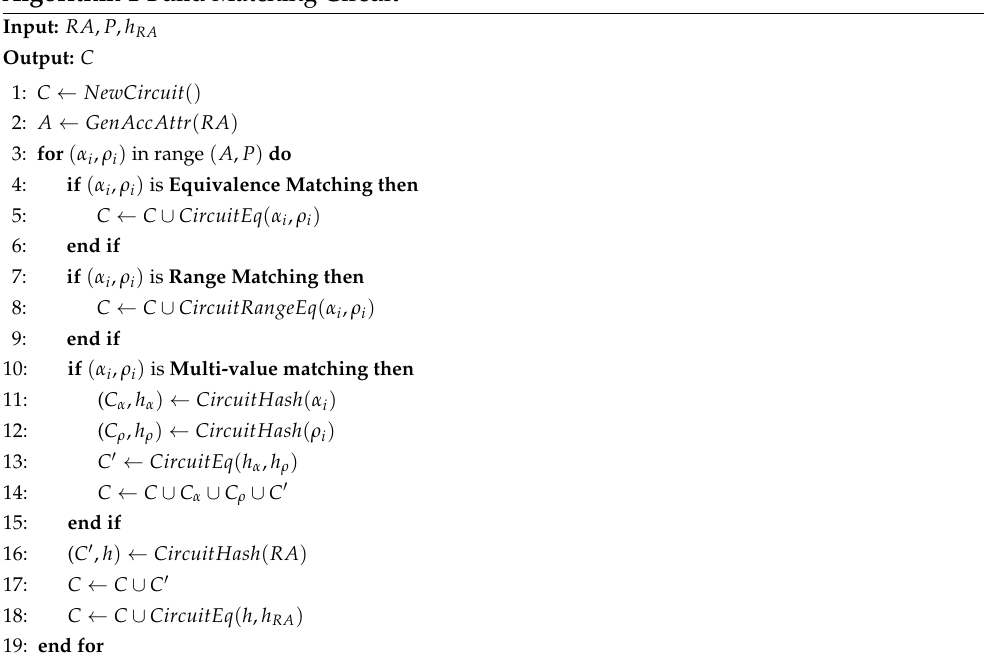
Algorithm 1 Build Matching